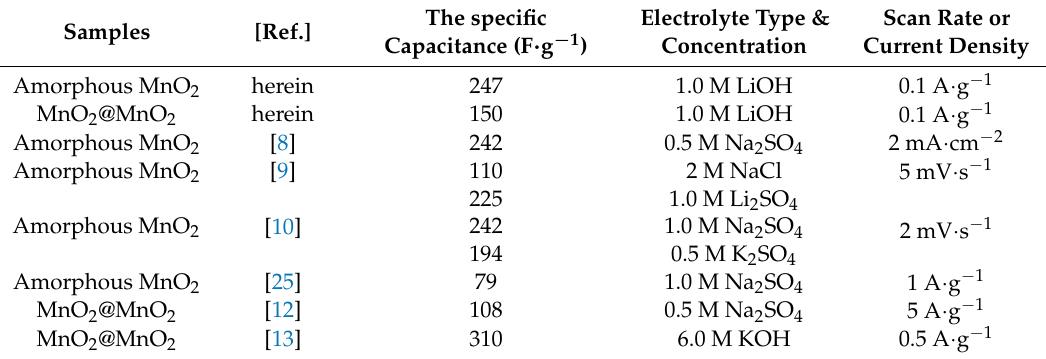
Table 1. Comparison of the specific capacitance of as-prepared electrodes to other reported amorphous MnO 2 and MnO 2 @MnO 2 electrodes.